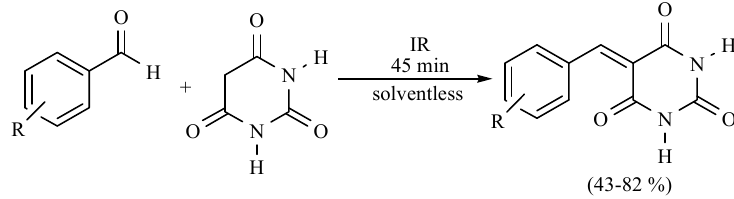
Scheme 3. Synthesis of benzylidenebarbituric acids.